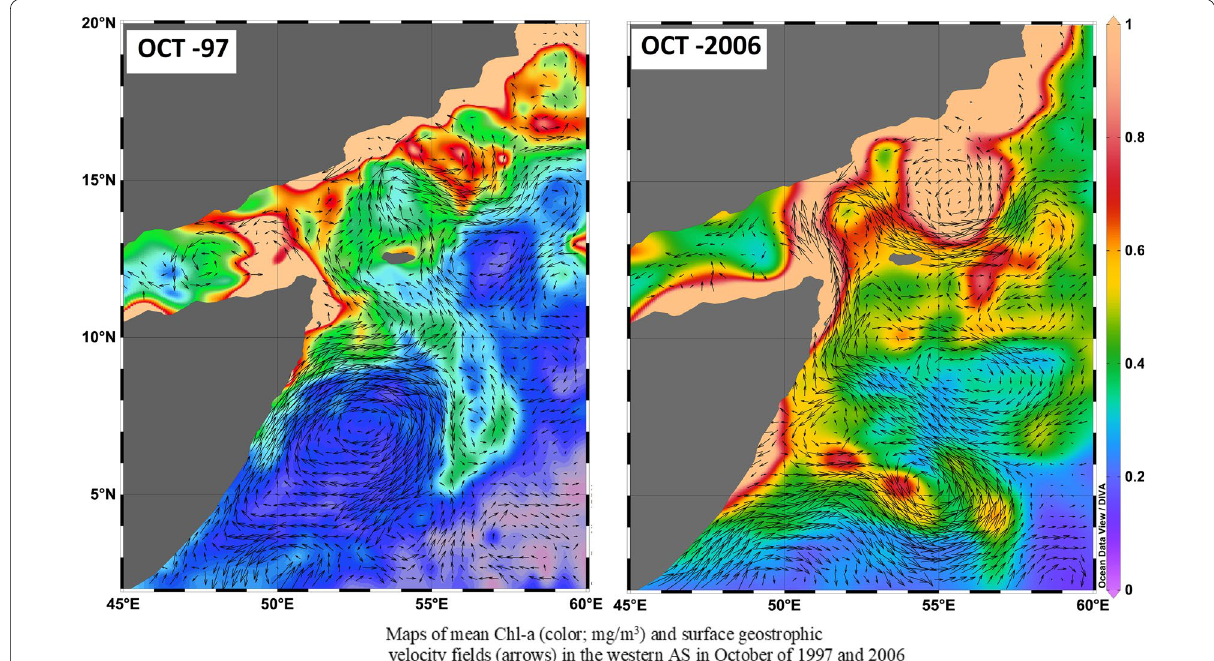
Fig. 11 Maps of mean Chl-a (color; mg/m 3 ) and surface geostrophic velocity fields (arrows) in the western AS in October of 1997 and